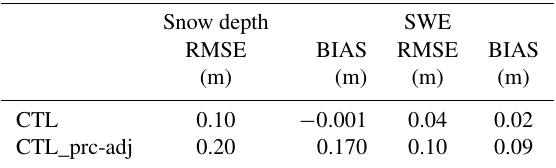
Table A1. SNOWPACK model RMSE and bias for the simulated snow depth and snow water equivalent variables in the CTL_prc- adj experiment and in the control run